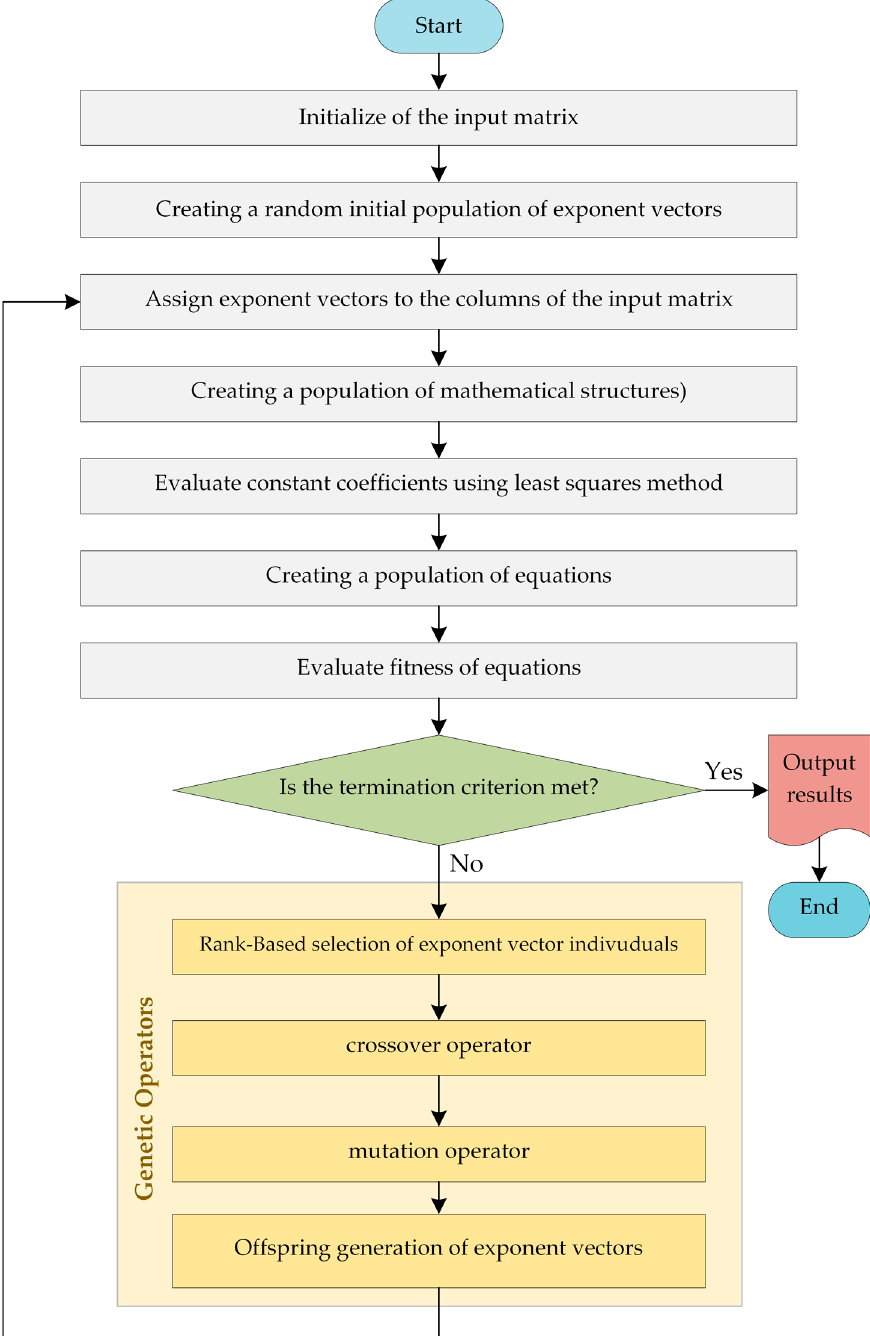
Figure 1. EPR flowchart [59].